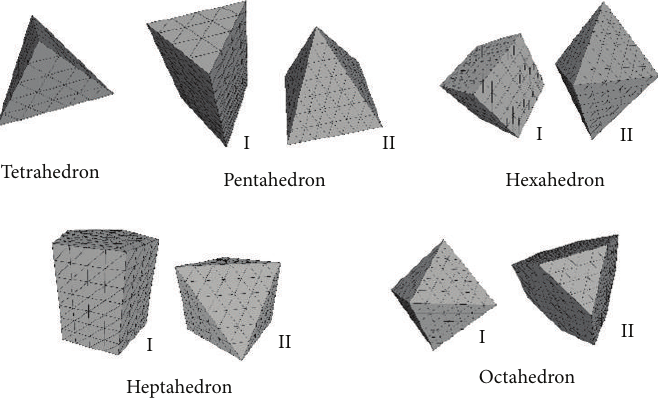
Figure 2: Nine regular polyhedra with facet numbers 4 ∼ 8.